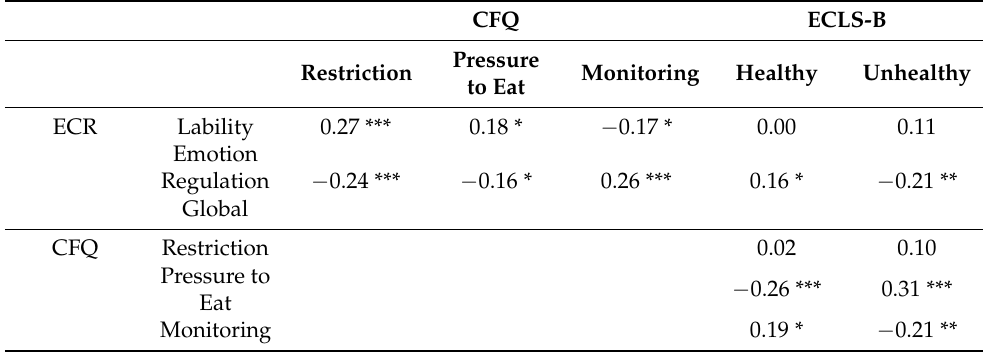
Table 2. Associations between ERC, CFQ, and ECLS-B